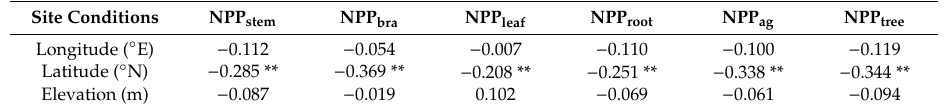
Figure 4. Net primary productivity (NPP) spatial distribution of P. massoniana forests in relation to longitude, latitude ( a ), and elevation ( b ). Table 2. Pearson correlations between site conditions and P. massoniana stem, branch, leaf, root, aboveground, and total tree net primary productivity (NPP) on a logarithmic (ln)